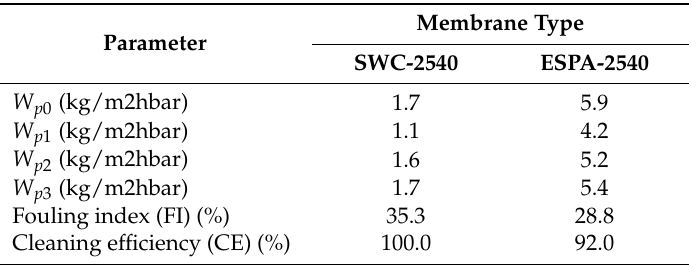
Table 3. Hydraulic permeability measurement and fouling index of reverse osmosis (RO) membranes ( W p 0 , initial water permeability; W p 1 , after the treatment with FGD wastewaters; W p 2 , after cleaning with water at 30 ◦ C; W p 3 , after acid cleaning at pH 4).